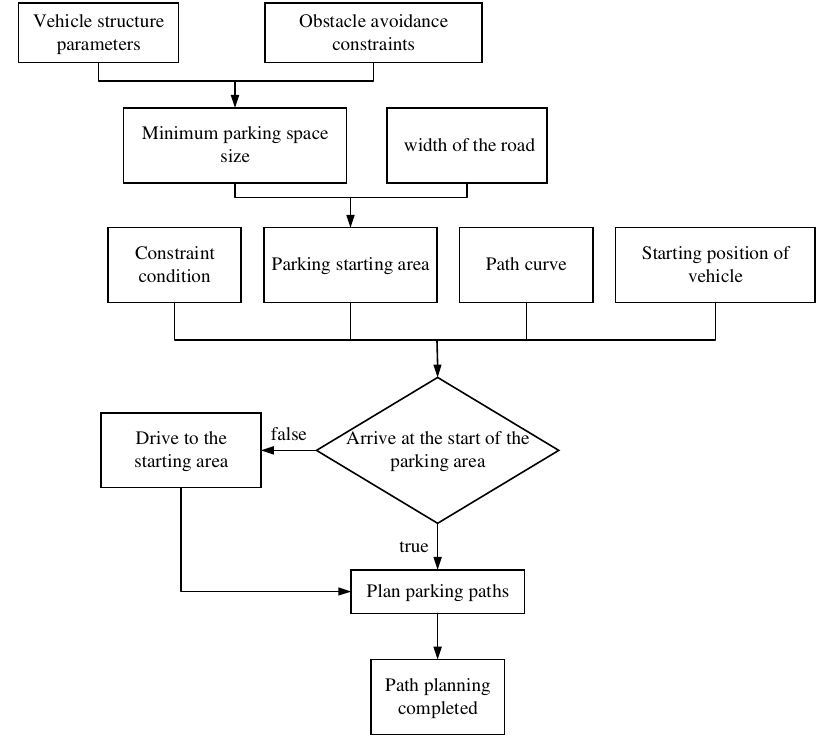
Figure 1. Parking path planning structural schematic diagram.